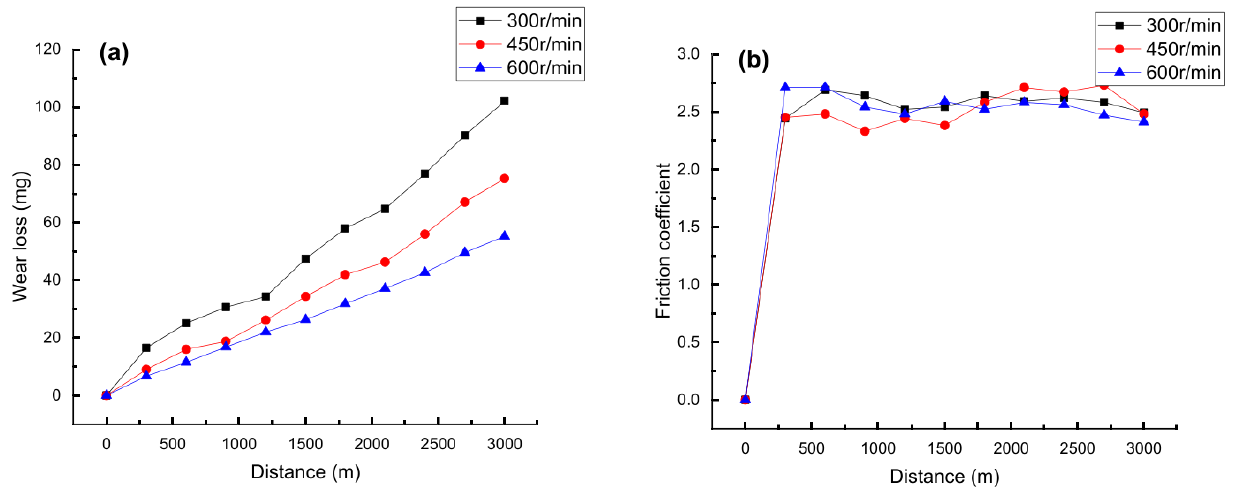
Figure 5. Variations of wear loss and friction coefficient with the sliding distance under different speeds (5 N, loam, moisture 0): ( a ) wear loss and ( b ) friction coefficient.